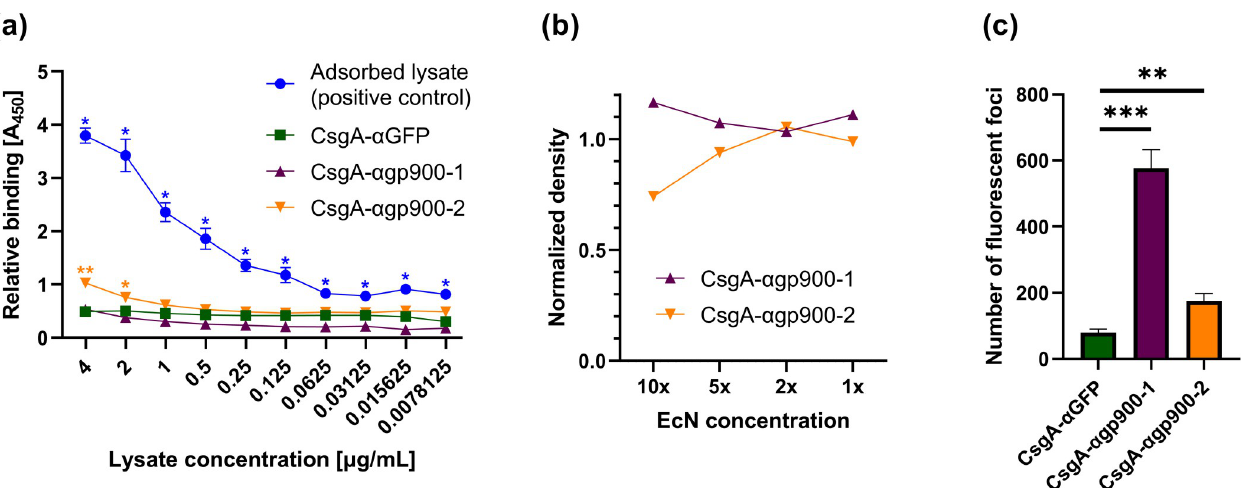
Fig 7. CsgA-VHHs can bind to the eukaryotic pathogen Cryptosporidium parvum . (a) ELISA demonstrating the ability of CsgA- α gp900-2 to bind gp900. PBP8 was adsorbed onto a well plate, followed by incubation with gp900-containing C . parvum lysate. In the positive control, no PBP8 was used, and the C . parvum lysate was allowed to directly adsorb onto the surface of the wells. Gp900, either bound to PBP8 or adsorbed to the surface, was detected using a non- competing anti-gp900 VHH, followed by an anti-Etag IgG-HRP conjugate. (b) Western blot analysis of gp900 binding to CsgA- α gp900-2. C . parvum lysate was incubated with PBP8 at different concentrations. After pelleting the PBP8, supernatant form was run on gel and subjected to Western blot to assess gp900 depletion. The gp900 band was detected by a specific non-competing VHH, followed by an anti-Etag IgG-HRP conjugate. Band intensity was normalized to a CsgA- α GFP negative control. (c) CsgA- α gp900-1 and -2 bind to C . parvum sporozoites. PBP8 was applied to immobilized and fixed sporozoites, followed by staining with anti-LPS Mab and anti-mouse IgG Alexa Fluor 568. Slides were inspected under TRITC filter and 5 images were taken under 200x magnification for each condition. Foci of PBP8 accumulation were quantified using ImageJ particle analyzer. Data presented as mean ± SEM. Two-way ANOVA (P < 0.0001) was performed to test presence of difference between conditions, P-values calculated by Welch’s t-test. � P < 0.05; �� P < 0.01; ��� P <